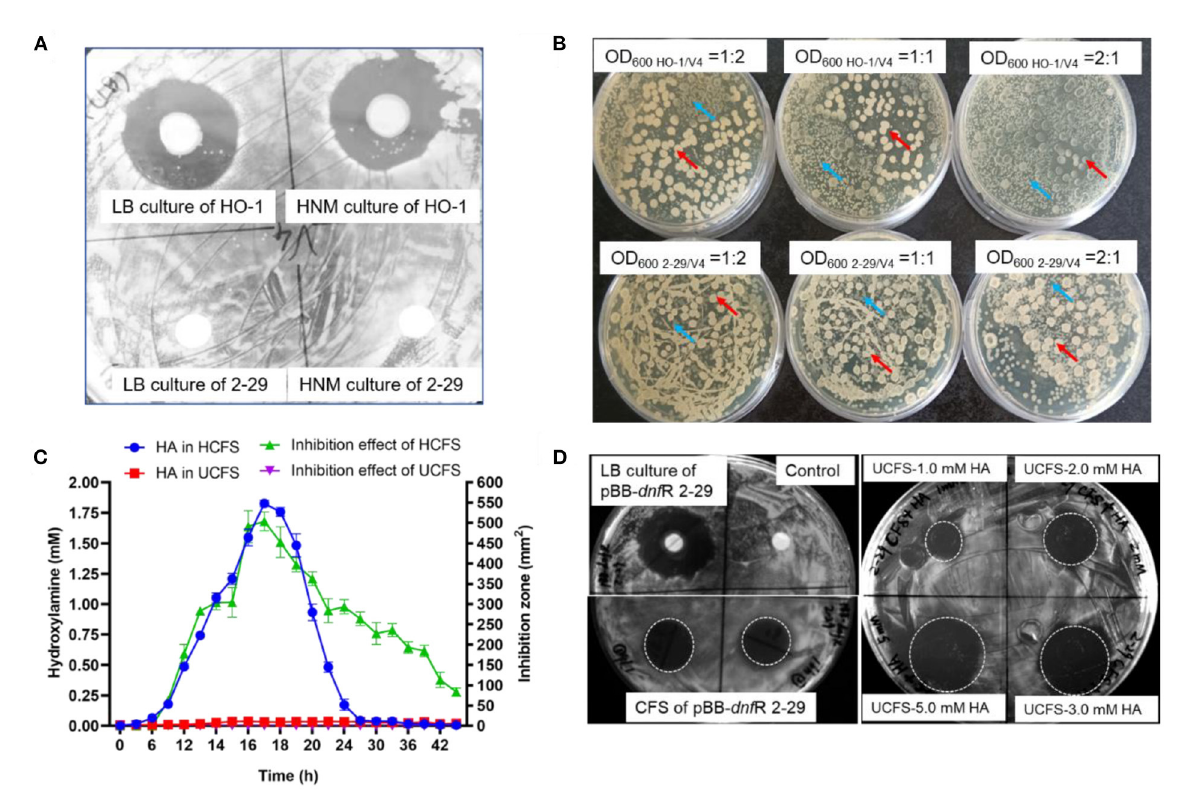
FIGURE1 Contact-independent interbacterial antagonism of A. ammonioxydans HO-1 toward B. velezensis V4. (A) Comparison of antagonistic behavior between A. ammonioxydans HO-1 and 2-29, the latter failing to inhibit B. velezensis V4. (B) A. ammonioxydans HO-1 showed more competitive advantage when co-cultured with B. velezensis V4 with the initial OD 600 ratios of 1:2, 1:1, and 2:1, respectively. Red arrow indicates B. velezensis V4 colonies, and blue arrow indicates A. ammonioxydans HO-1 or 2-29 colonies. (C) HA production and inhibition effect of HCFS/UCFS (CFS of A. ammonioxydans HO-1/2-29) at different time points in culture. Error bar represents standard deviations of three replicates. (D) The inhibitory capacity of the complementation strain of A. ammonioxydans 2-29 (pBB- dnfR ) and UCFS containing specified HA concentrations